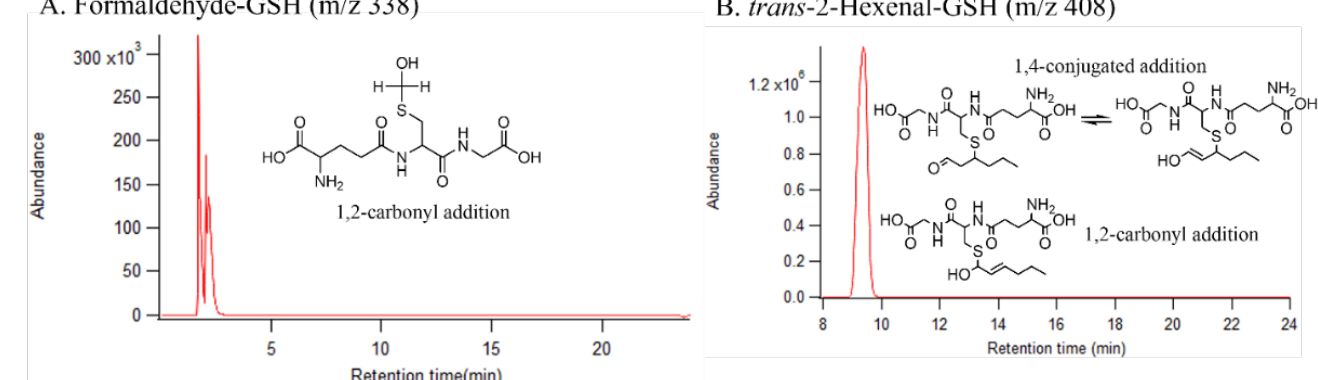
Figure 3. LC/ESI-QTOFMS EICs showing adduct formations between ( A ) formaldehyde-GSH and ( B ) trans-2-hexenal-GSH. Both EICs were background subtracted by GSH blank sample.